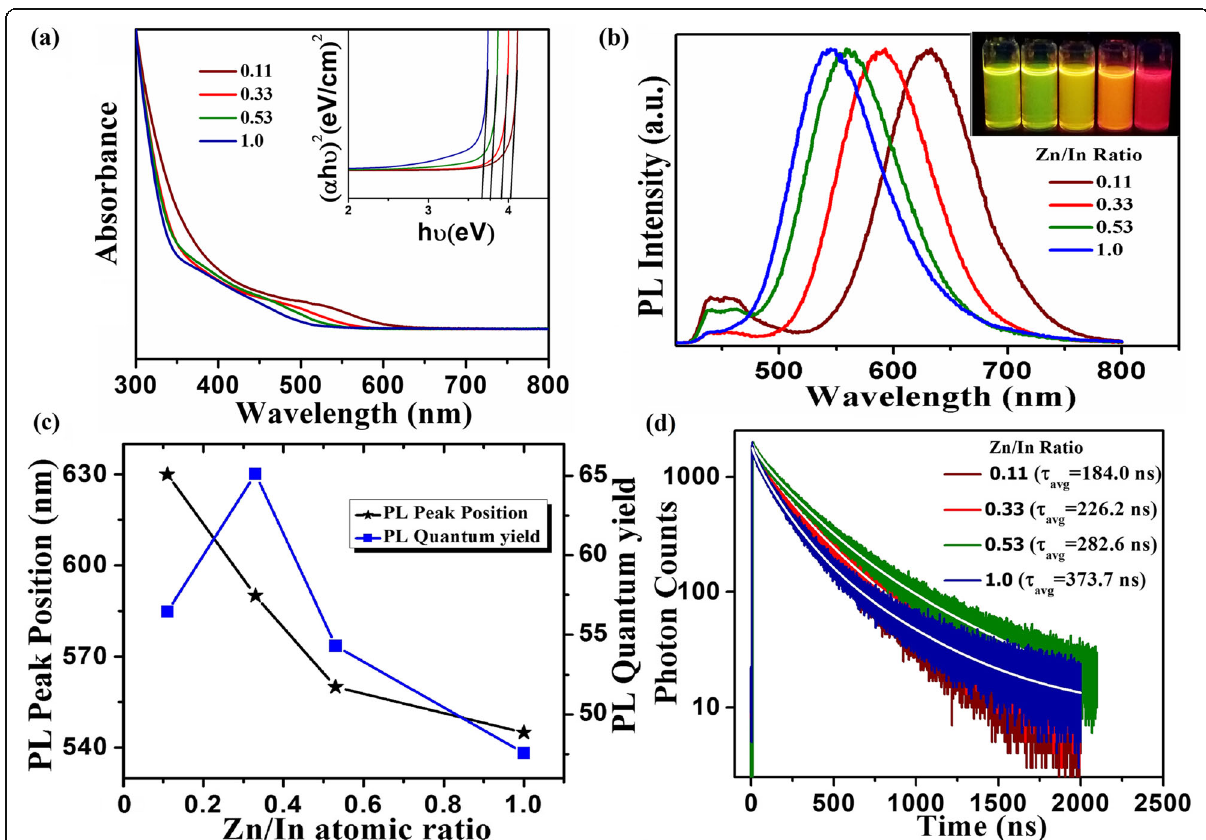
Fig. 4 a UV-visible absorption and b photoluminescence spectra of ZnInS:Cu/ZnS core/shell CNCs as a function of the Zn/In stoichiometric composition. The QY attained for different samples with Zn/In ratio 0.11, 0.33, 0.53, and 1.0 is 56.0, 65.0, 55.0, and 48.0%, respectively. The inset in a shows the calculated energy band gap of ZnInS:Cu/ZnS CNCs. c Shift of the PL peak position and PL quantum yield with respect to change in Zn/In. d PL decay curves of ZnInS:Cu/ZnS CNCs for different Zn/In